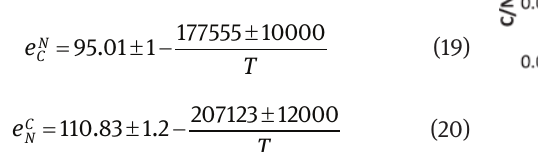
Fig. 5: Solubility limits of carbon and nitrogen as functions of temperature during simultaneous saturation. The solid curves represent the iterative solutions of Eqs. 19 and 20, while the dashed lines are the linear approximations of Eqs. 25 and